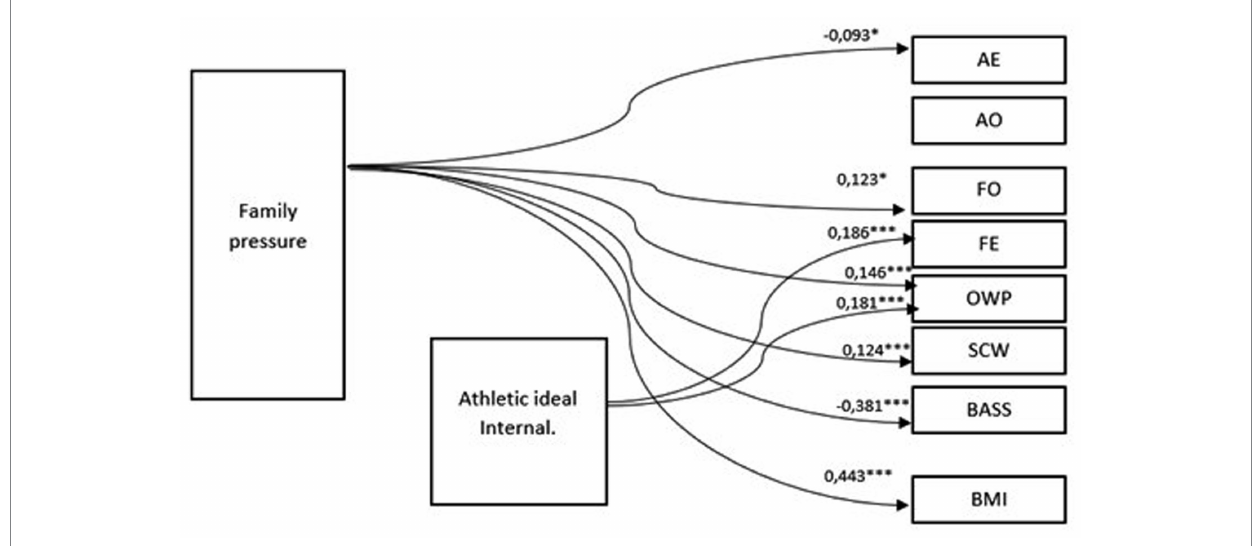
FIGURE 3 Path model (SEM) for young Polish women. N = 154; Chi 2 = 3.20; df = 1; p > 0.05; RMSEA = 0.050; CFI = 0.994. * = p < 0.05; *** = p < 0.001 (two tailed